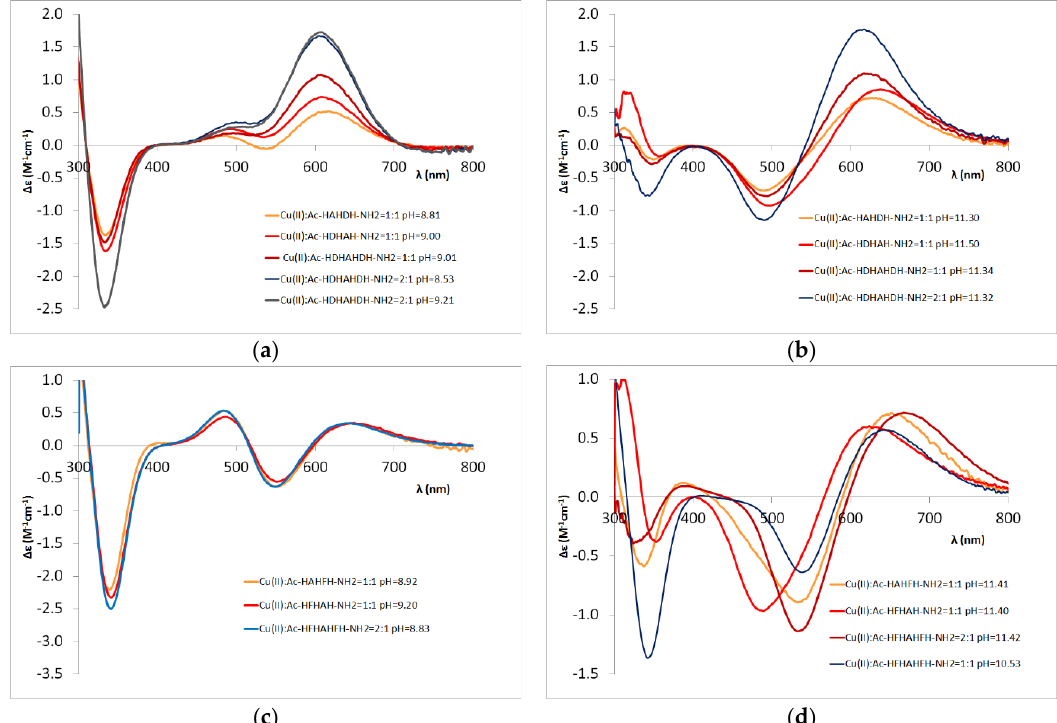
Figure A5. The CD spectra of the Cu(II)-L system, at different ratio and pH. L is aspartic acid containing penta- and hepta-peptides, pH 8.5–9.2 ( a ), pH 11.3–11.5 ( b ); L is phenylalanine containing penta- and heptapeptides, pH 8.8–9.2 ( c ), pH 11.4–11.6 ( d